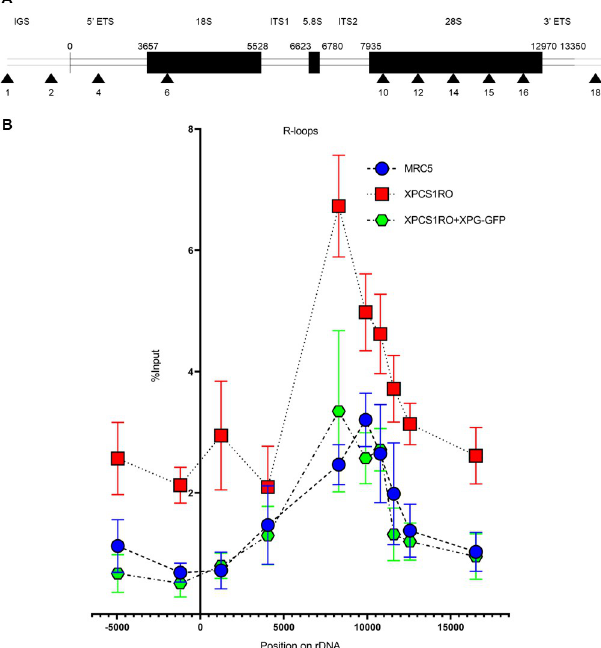
Fig 3. The unresolved R-loops are increased along the rDNA unit in the absence of XPG. A) Scheme of the human rDNA unit with the position of all the primers used. IGS: InterGenic Spacer; ETS: External Transcribed Spacer; ITS: Internal Transcribed Spacer. B) DRIP-qPCR in MRC5-SV, XPCS1RO-SV and XPCS1RO-SV+XPG-GFP cell lines. Signal was quantified as percentage of input DNA and normalized using controls treated with RNase H. Error bars represent the SEM of three independent